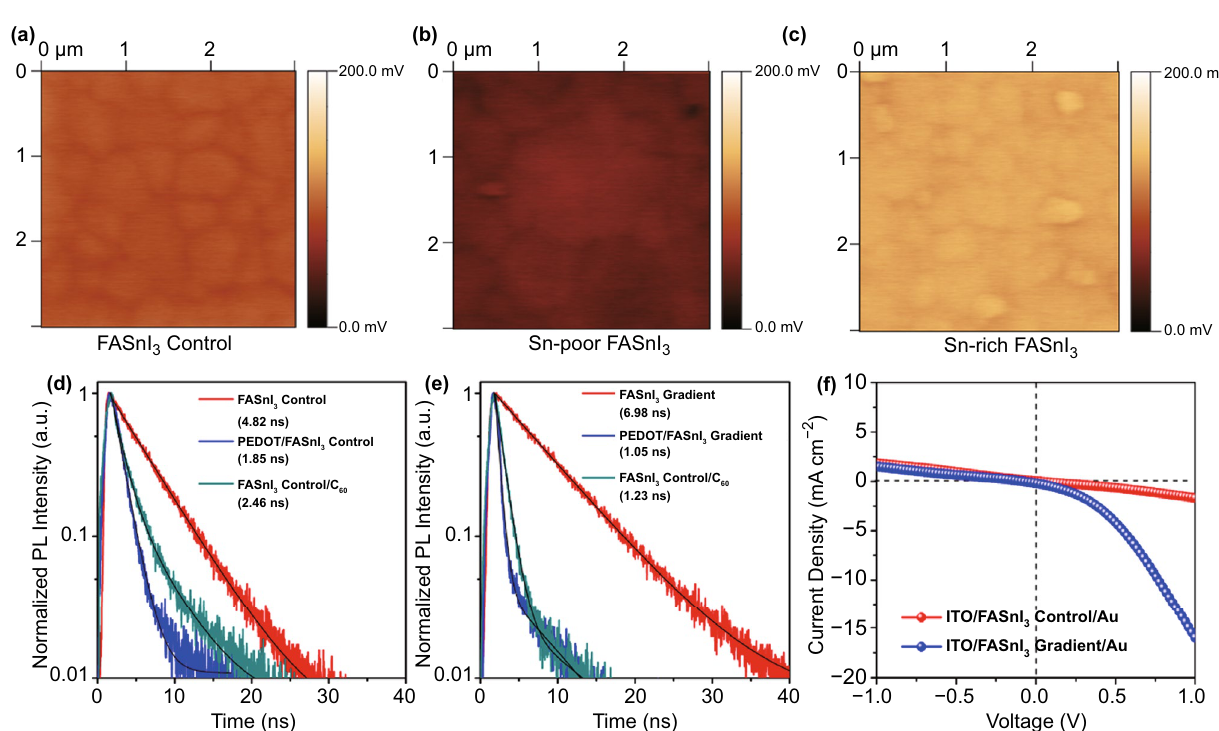
Fig. 4 Surface potential mapping images of the a control, b Sn-poor, and c Sn-rich FASnI 3 perovskite films deposited on the PEDOT:PSS/ ITO substrate. TRPL spectra of the d control and e gradient FASnI 3 films coated on the quartz substrate before and after contact with C 60 or PEDOT:PSS layers. f Output dark current plots as a function of the applied voltage for the ITO/FASnI 3 control/Au and the ITO/FASnI 3 gradient/ Au